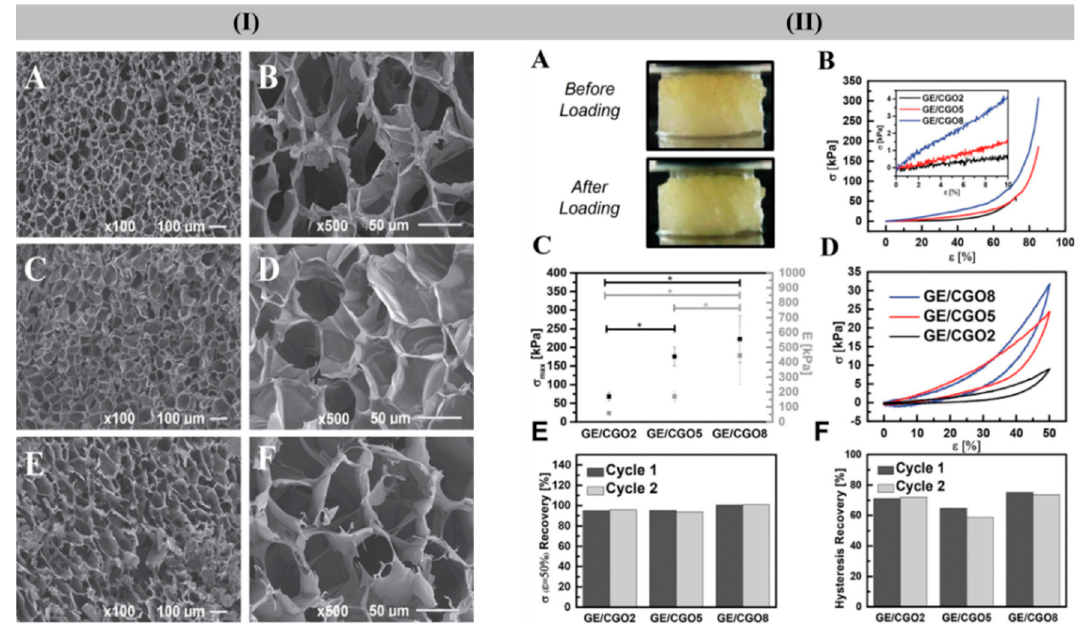
Figure 7. ( I ) SEM images of freeze-dried GE/CGO2 ( A , B ); GE/CGO5 ( C , D ); and GE/CGO8 ( E , F ) sponges at scale bar of 100 µ m and 50 µ m, respectively. ( II ) Mechanical analysis: ( A ) digital images of GE/CGO8 hydrogels before and after compression (until 90% strain); ( B ) stress–strain curves of GE/CGO hydrated hydrogels (inset: magnified region (0–10% of strain) for measuring compressive modulus ( E ); ( C ) maximum compressive stress ( σ max ) and modulus ( E ) of GE/CGO sponges; ( D ) loading–unloading cycles of GE/CGO sponges until 50% of strain, and ( E , F ) recovery of the compressive stress at 50% of strain and hysteresis upon three successive loading–unloading cycles, respectively. Reproduced with the permission from [7]. Copyright 2019, John Wiley and Sons.